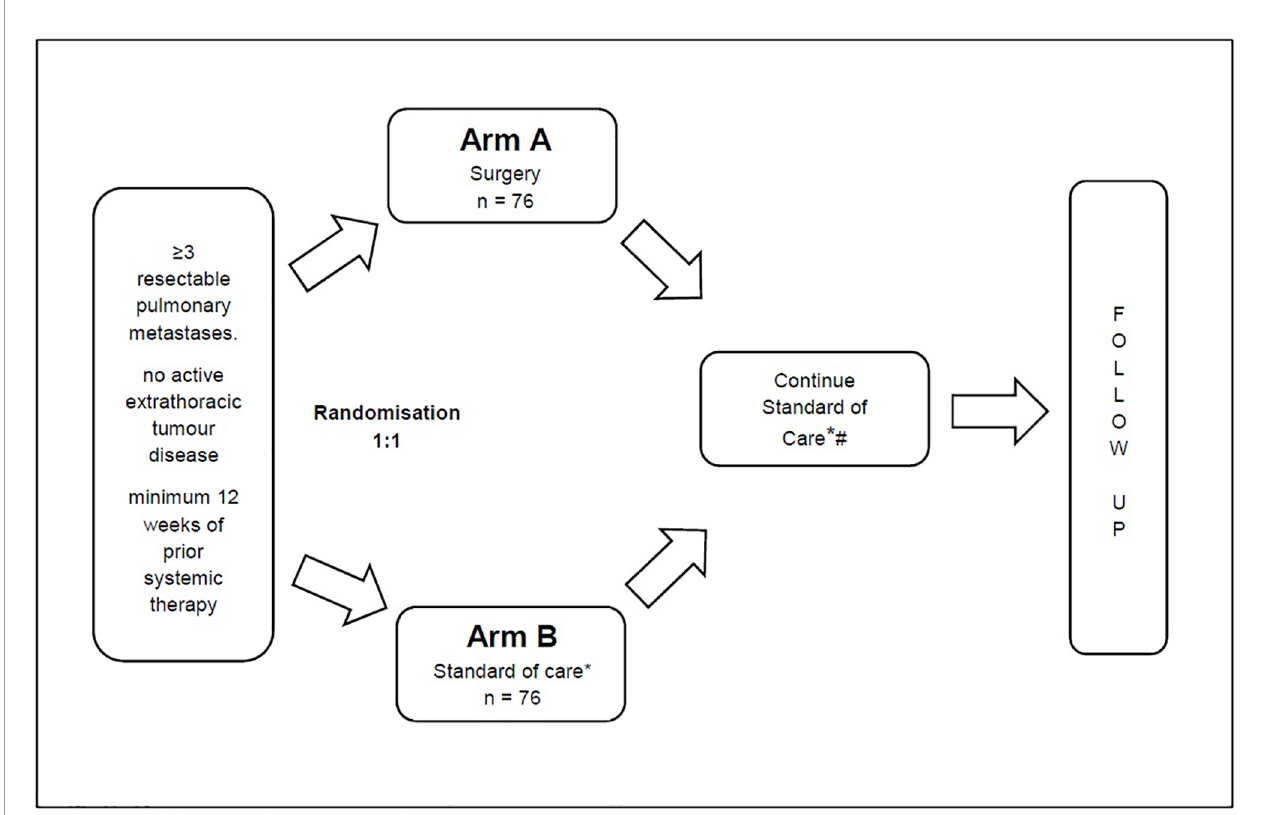
FIGURE 1 | * For Arm B this includes the possibility of local ablative measures such as SBRT. # For Arm A (Surgery) this includes the possibility of